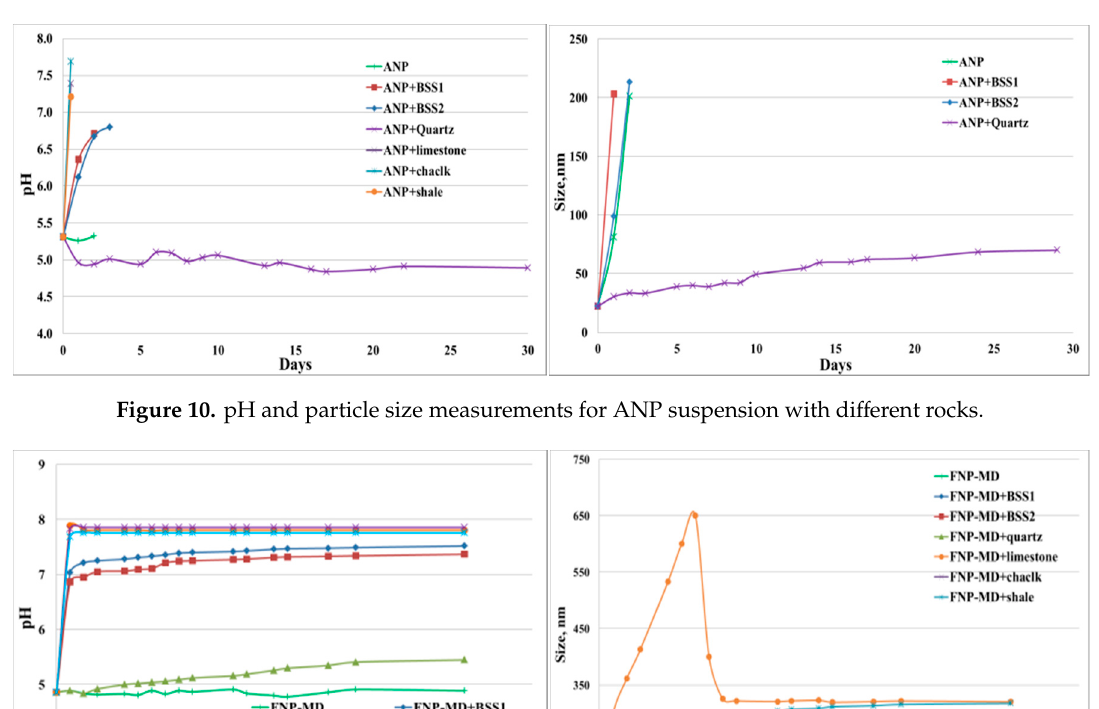
Figure 9. pH and particle size measurements for FNP suspension with different rocks.